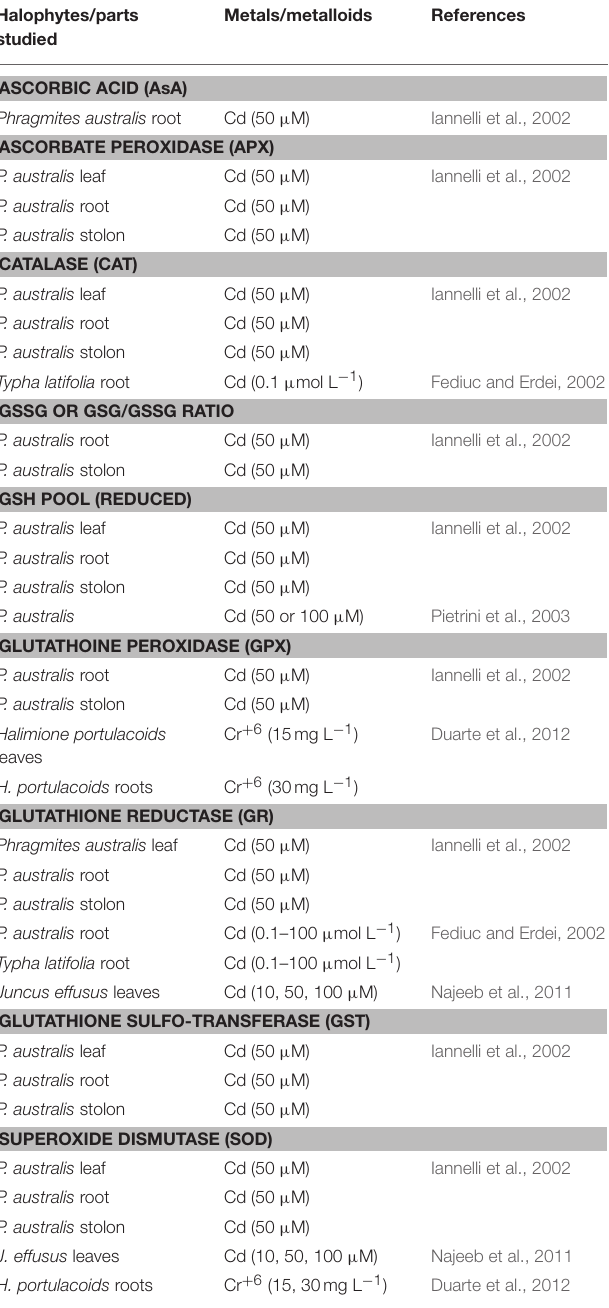
TABLE 1 | Representative studies reporting increases in major components of antioxidant defense system in metal/metalloid-exposed salt marsh halophytes.